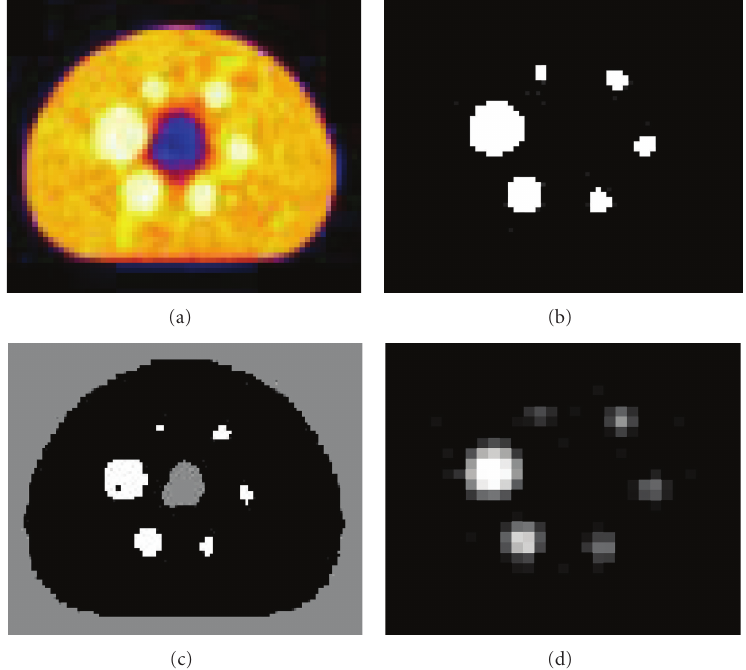
Figure 5: Phantom data set 1: (a) Original PET image (168 × 168), (b) thresholded image (168 × 168), (C) clustered image (168 × 168), (d) segmented image (84 × 84) using ANN and MRA, zoomed by a factor of 2.